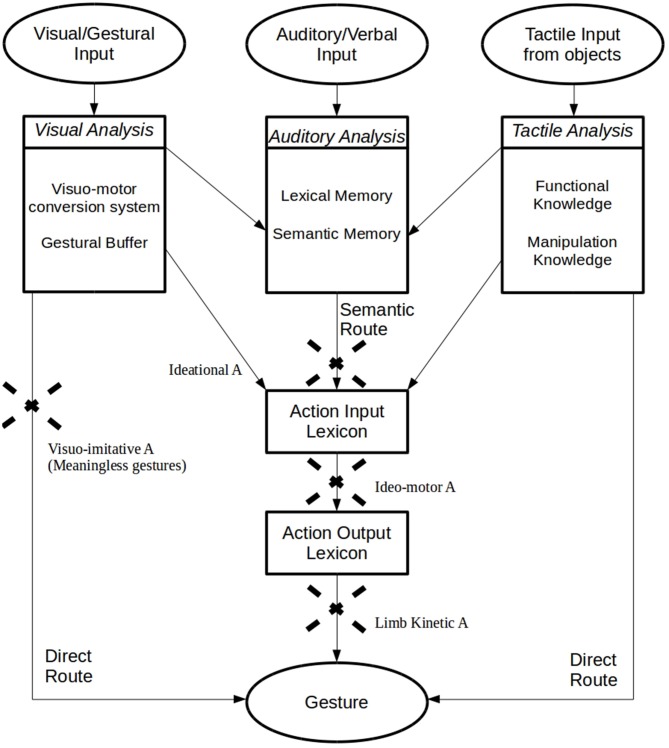
Graphical representation of the “Dual-Route Model” (Gonzalez Rothi et al., 1991), with the additional proposal for the Visuomotor Conversion System, Gestural Buffer (Cubelli et al., 2000), Functional and Manipulation Knowledge (Roy and Square, 1995) and the Selective Tactile Route (Graham et al., 1999).